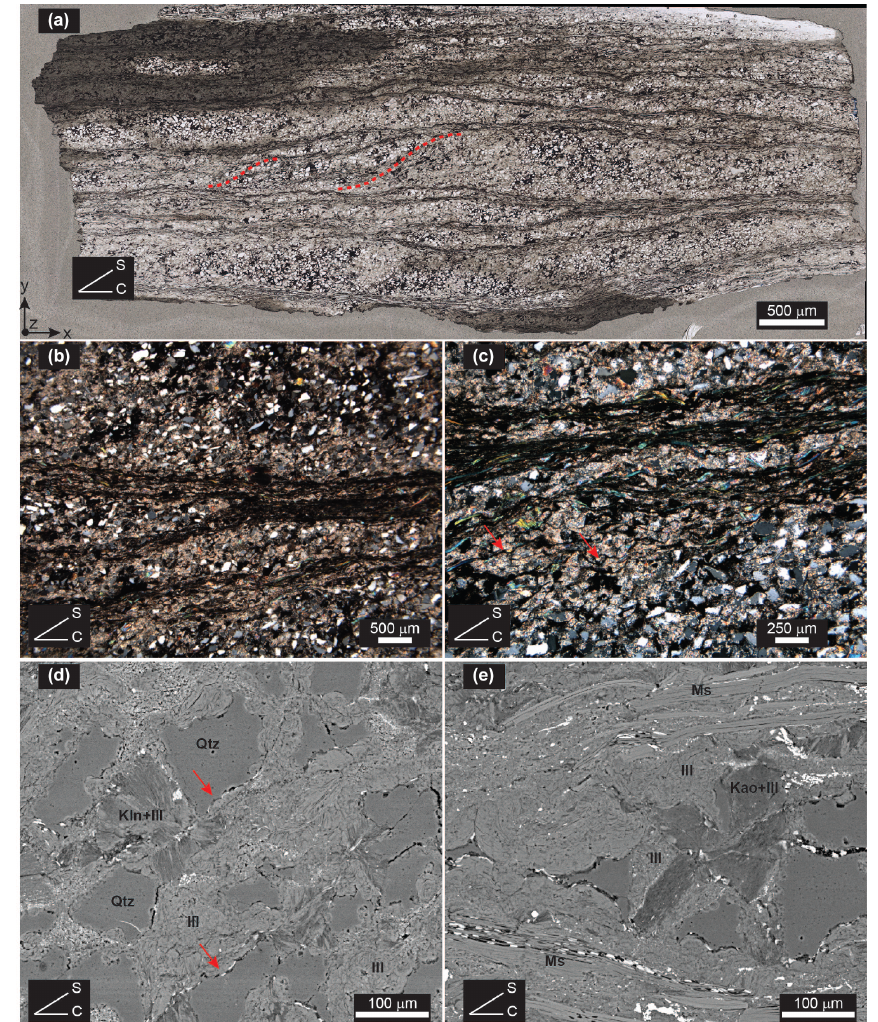
Figure 4. Microstructures of a faulted sample from Julia Creek 1 well (depth 360m); petrographic thin section is cut parallel to the inferred shear direction. (a) Whole thin section image collected using an optical microscope in plane polarized light showing composite S–C foliation (dashed red lines illustrate the orientation of the S plane). (b) Optical microscope image in cross-polarized light showing phyllosilicate enriched C planes and the oblique S foliation. (c) Optical microscope image in cross-polarized light showing alignment of opaque insoluble minerals along the S plane (highlighted by the red arrows) indicative of pressure solution. (d, e) Scanning electron microscope images of the deformed rock showing corroded boundaries in detrital quartz (Qtz) highlighted by the red arrows, authigenic kaolinite and illite (Kln; Ill) and detrital muscovite (Ms) aligned along the C